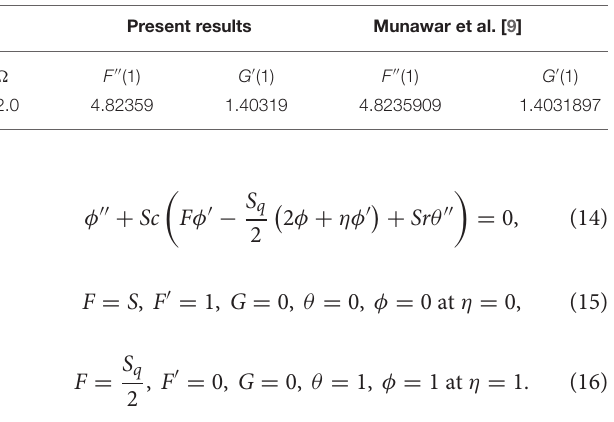
TABLE 3 | Comparative values of F ′′ (1) and G ′ (1) for value of (cid:127) when S M 0.5 and S q = = =